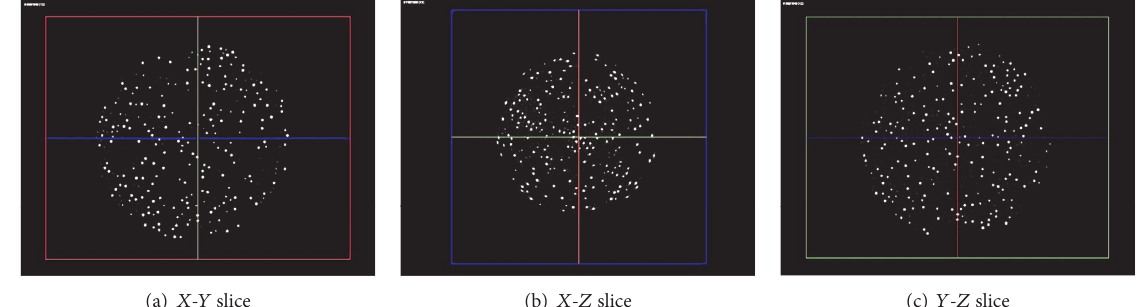
Figure 6: Distribution of TRISO particles in 2D.